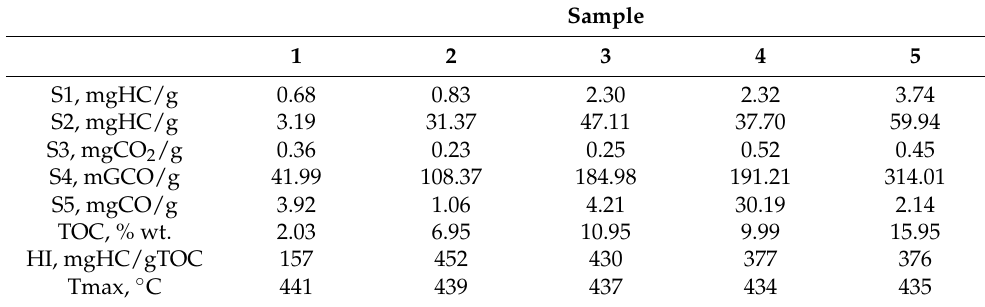
Table 1. Pyrolysis data for the studied rock samples.